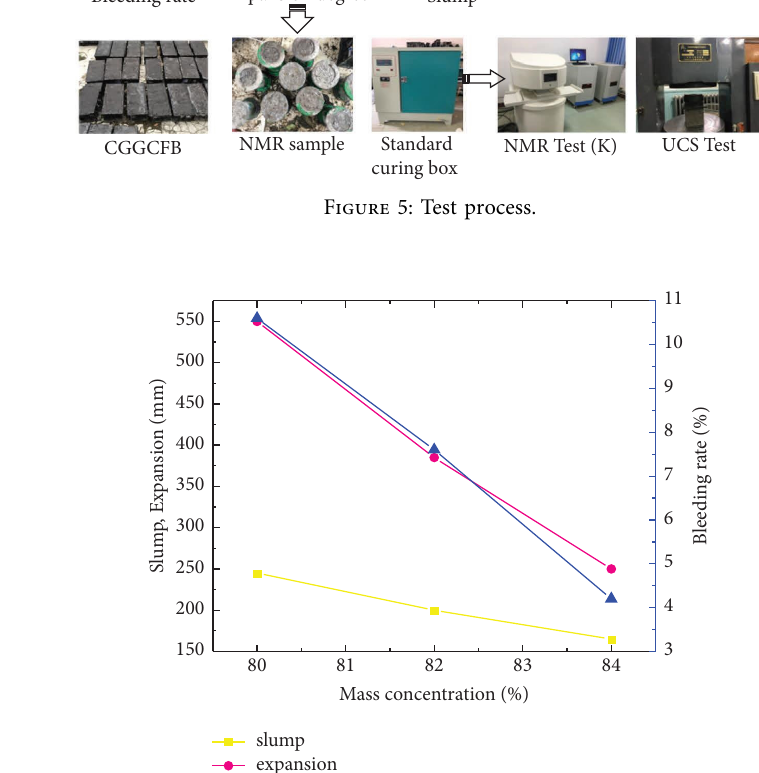
Figure 6: Working performance under diferent mass